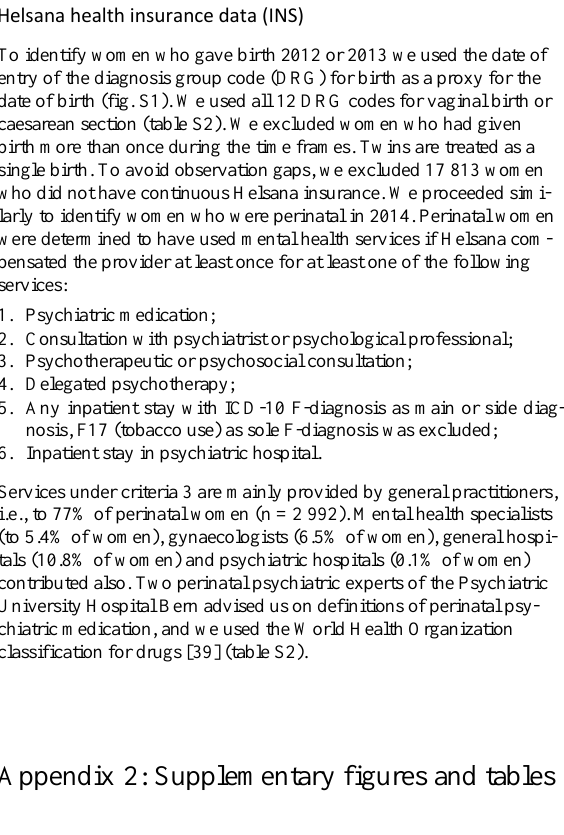
Figure S2: Percentages of diagnostic groups of mental disorders (% of all recoded F- diagnoses; n = 1174); ICD-10 F-diagnoses at the 2-character level * recorded in inpatient obstetric care. Medical Statistics of Hospi- tals, 2012. * WHO. The ICD-10 classification of mental and behavioural disorders: Clinical descrip- tions and diagnostic guidelines.